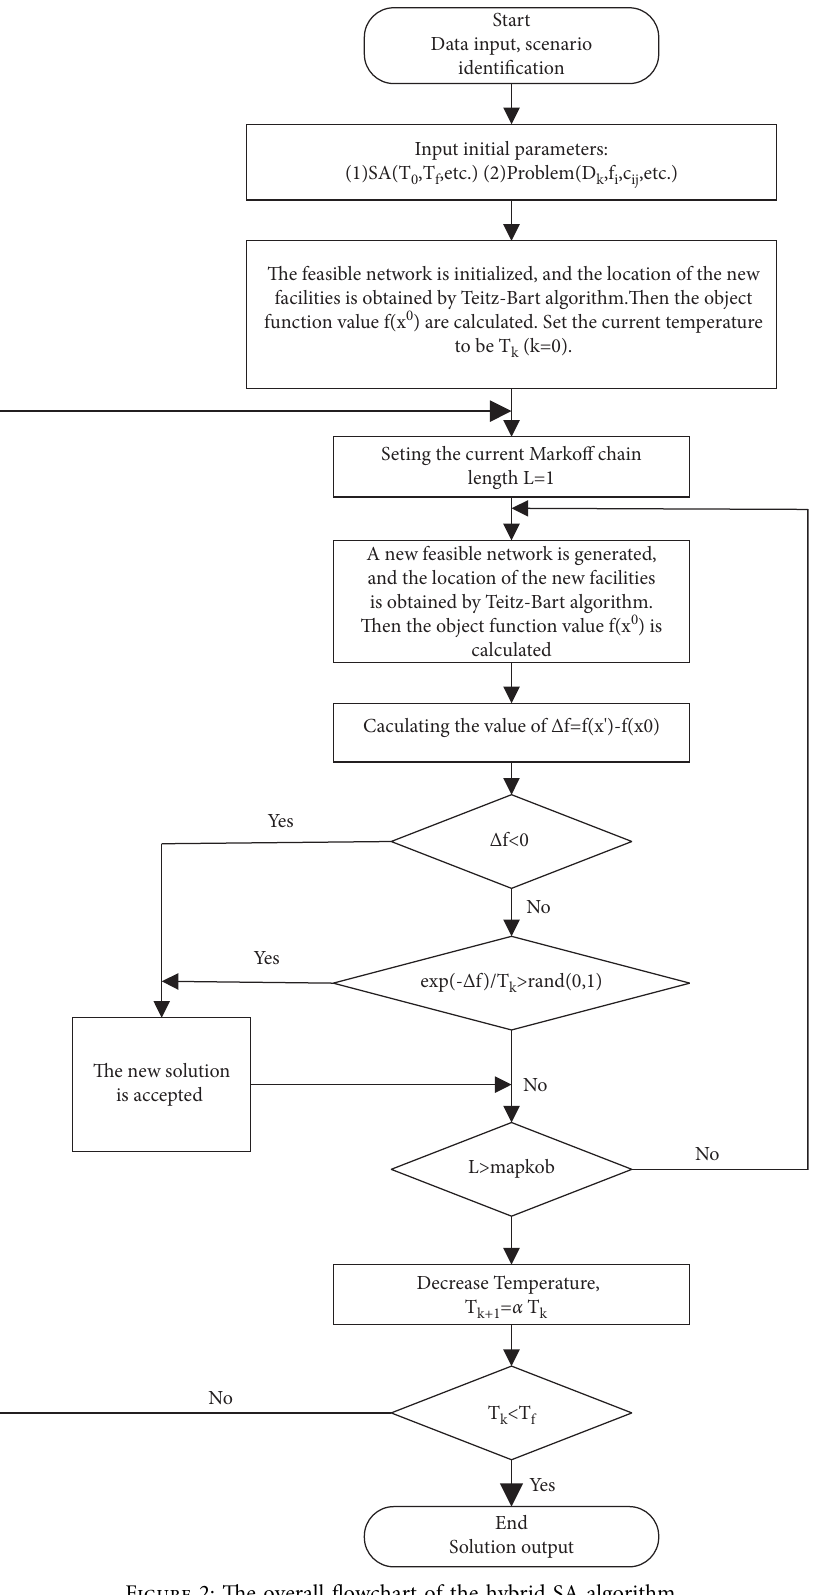
Figure 2: The overall flowchart of the hybrid SA